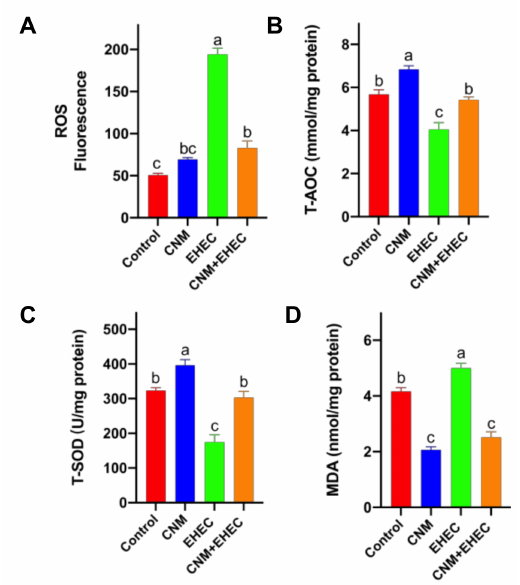
Figure 9. Effects of CNM treatment on oxidative stress induced by E. coli O157 infection in IPEC-J2. Cells were cultured with or without CNMs in the presence or absence of E. coli O157 . ( A ) Quantitative assay of ROS in IPEC-J2 cells; ( B ) T-AOC; ( C ) T-SOD; ( D ) MDA content. These enzymes were detected with commercial reagent kits. Data are given as means ± SEM (n = 6). Means with different lowercase letters differ significantly by Tukey’s test ( p <